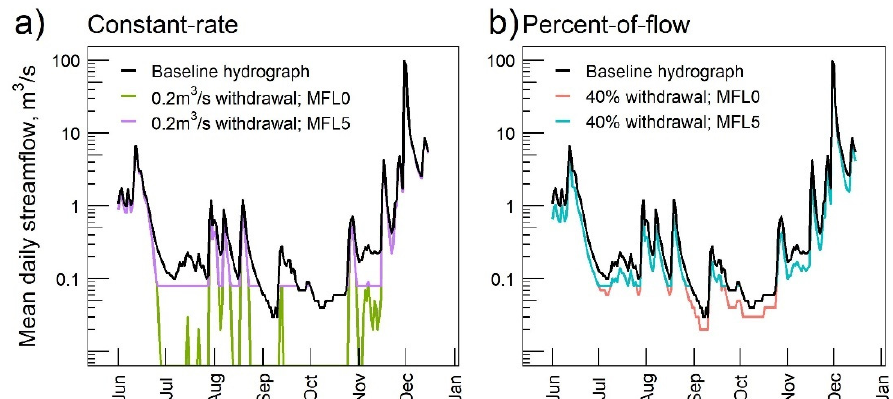
Figure 2. Example daily hydrographs of ( a ) constant-rate and ( b ) percent-of-flow water-withdrawal scenarios and minimum flow levels (MFLs). MFL0 hydrographs represent the absence of any MFL protection; MFL5 represents a MFL set at 5% of the mean annual flow. Daily streamflow values extending below y-axis represent flows at or near 0 m 3 /s on log10 scale.